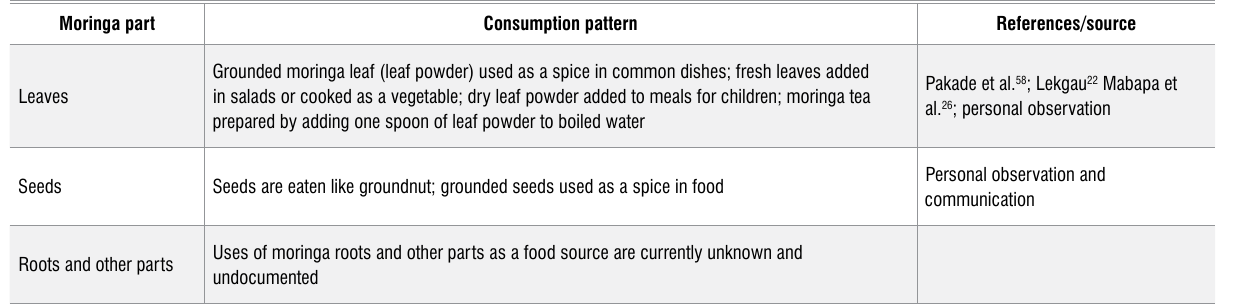
Consumption patterns of moringa for nutritional purposes in South Africa Moringa part Consumption